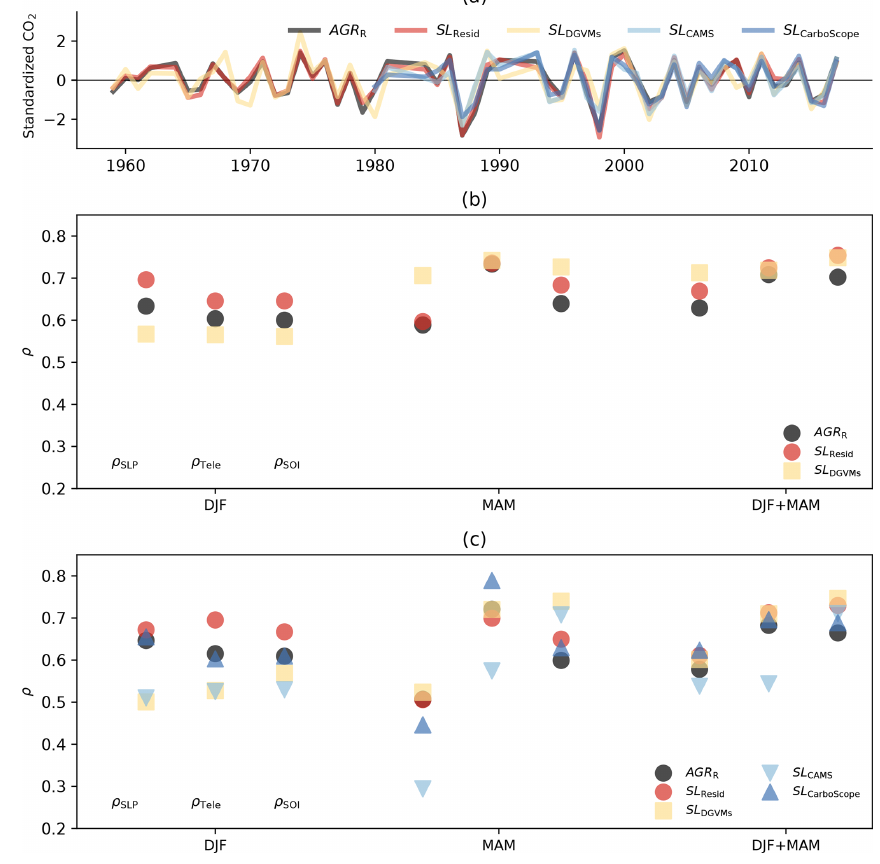
Figure 2. (a) Standardized annual observed and modeled CO 2 time series over the period 1959–2017 (AGR R in black, SL Resid in red, and SL DGVMs in yellow) and in the period 1980–2017 (SL CAMS in light blue and SL CarboScope in dark blue). The CO 2 time series have all been detrended as described in Sect. 2. Note that the AGR R , SL Resid , and SL DGVMs in the period 1980–2017 are detrended data based on their relevant period; compared with detrended data based on 1959–2017, the difference is negligible. (b) Pearson correlation of predicted vs. observed and modeled CO 2 time series based on the ridge regression with SLP fields ( ρ SLP ) or teleconnection indices ( ρ Tele ) as pre- dictors. Additionally, the Pearson correlation of predicted vs. observed and modeled CO 2 time series by linear regression is based on the single predictor of the SOI index ( ρ SOI ). SLP fields, teleconnection indices, and SOI are aggregated for different seasons: DJF, MAM, and DJF + MAM. Panel (b) shows results for 1959–2017 and panel (c) for 1980–2017. Note that in panel (c) , the ρ SLP of SL CAMS using MAM SLP as a predictor has significance P = 0 . 09, and all others have significance P < 0 .